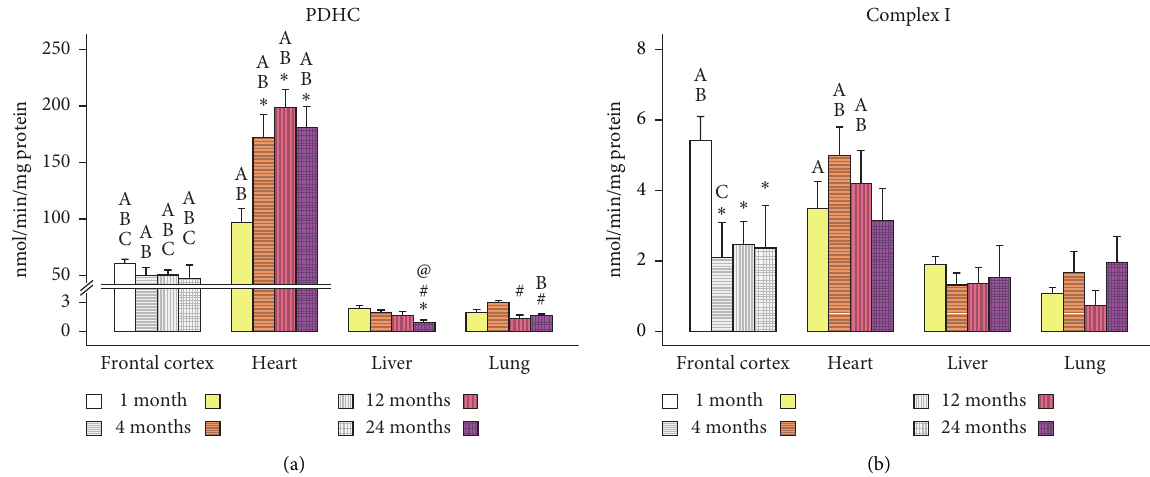
Figure 3: Age-dependent changes in activities of PDHC (a) and Complex I (b) enzymes in different organs. Values are expressed as means ± SEM from n � 5 observations/group. The differences between pairwise comparisons were considered statistically significant at p < 0 . 05. ∗ Significantly different from 1M rats; # significantly different from 4M rats; @ significantly different from 12M rats; A significantly different from lung; B significantly different from liver; C significantly different from heart; SEM, standard error of the mean. Grey-scale bars represent frontal cortex data from our previous report (adapted from Pandya et al. [23], with permission). Note the y -axis scale difference between frontal cortex and heart versus liver and lung.